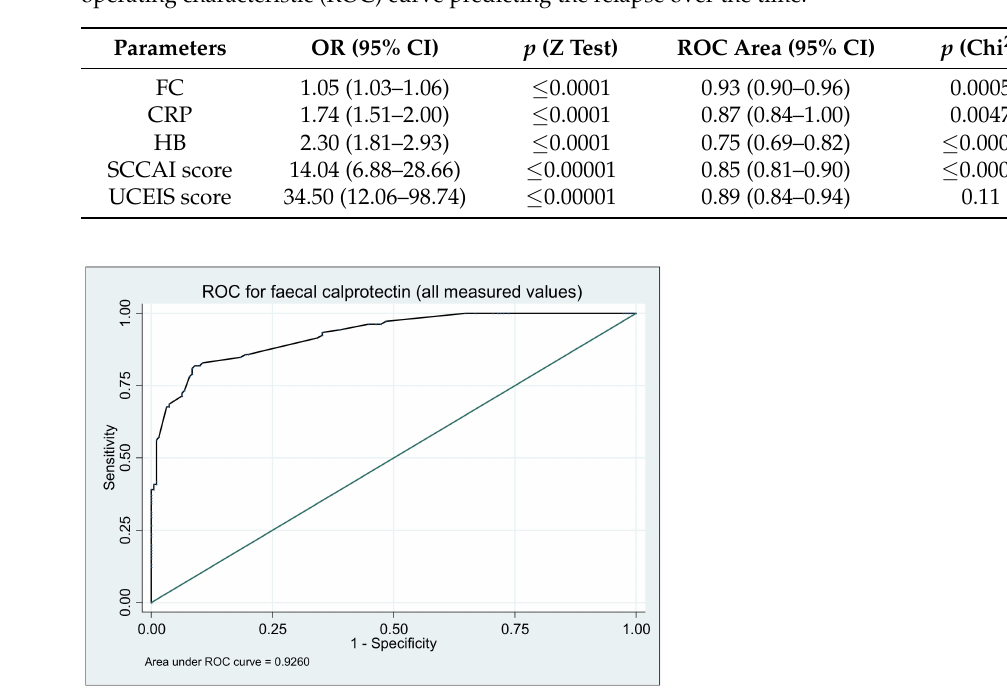
Table 2. Association between different parameters (odds ratio, OR) and relapse and the receiver operating characteristic (ROC) curve predicting the relapse over the time.